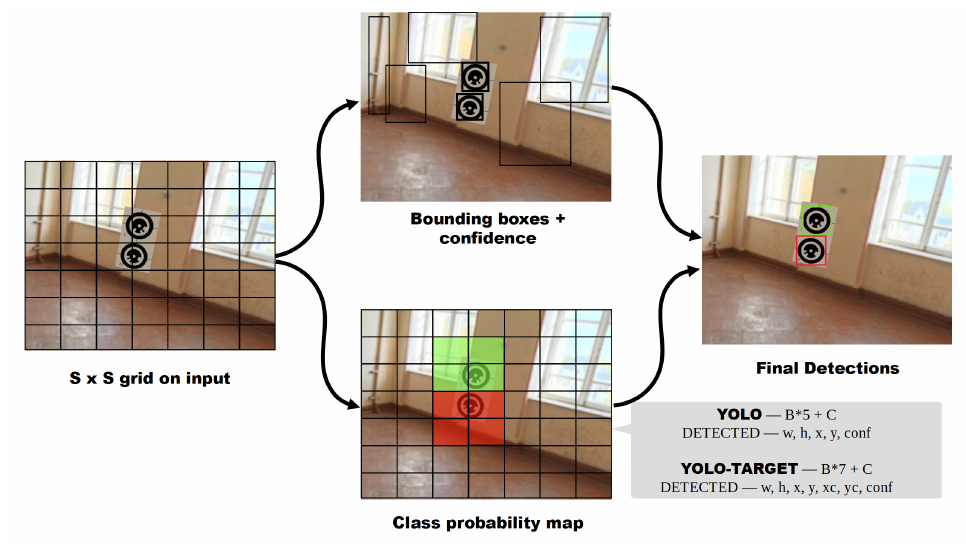
Figure 3. YOLO-Target model. It divides the image an S x S grid for each grid cell predicts B bounding boxes with centers, confidence for those Boxes, and C class probabilities. These predictions are encoded as an S x S x (B * 7 + C) tensor.